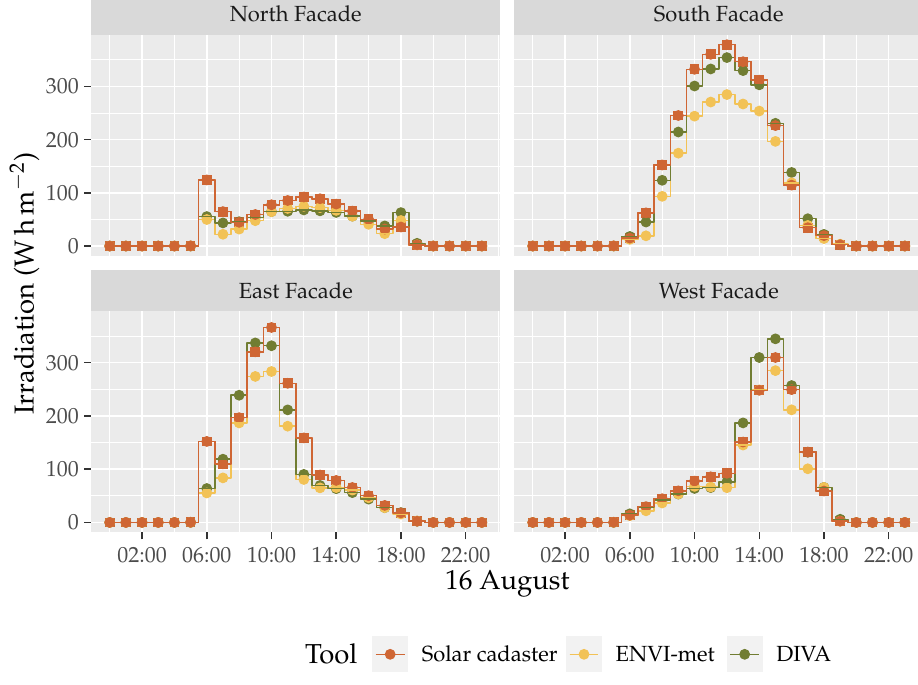
Figure 12. Spatial average irradiance received on the facades for the homogeneous district in August.